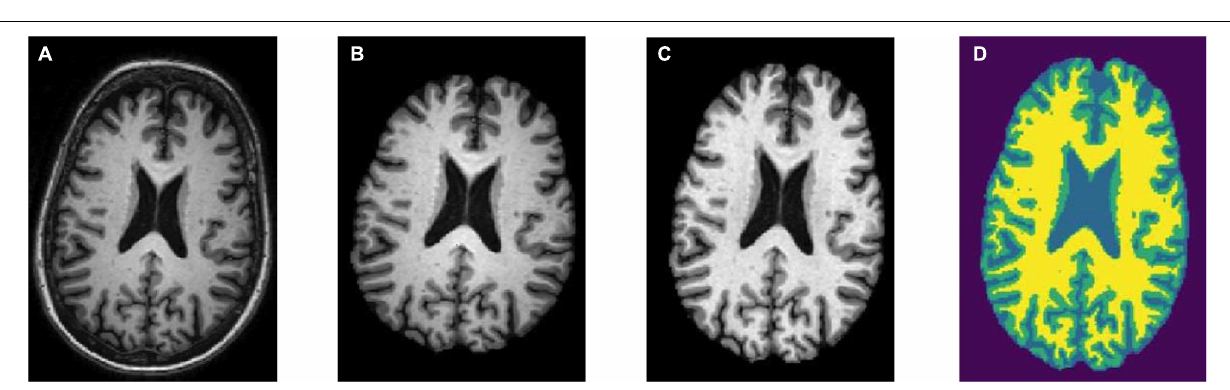
FIGURE 2 | Preprocessing steps: (A) raw bran MRI, (B) skull stripped MRI, (C) bias field corrected MRI, and (D) tissue segmented MRI (WM is denoted in yellow, GM is denoted in green, and CSF is denoted in light